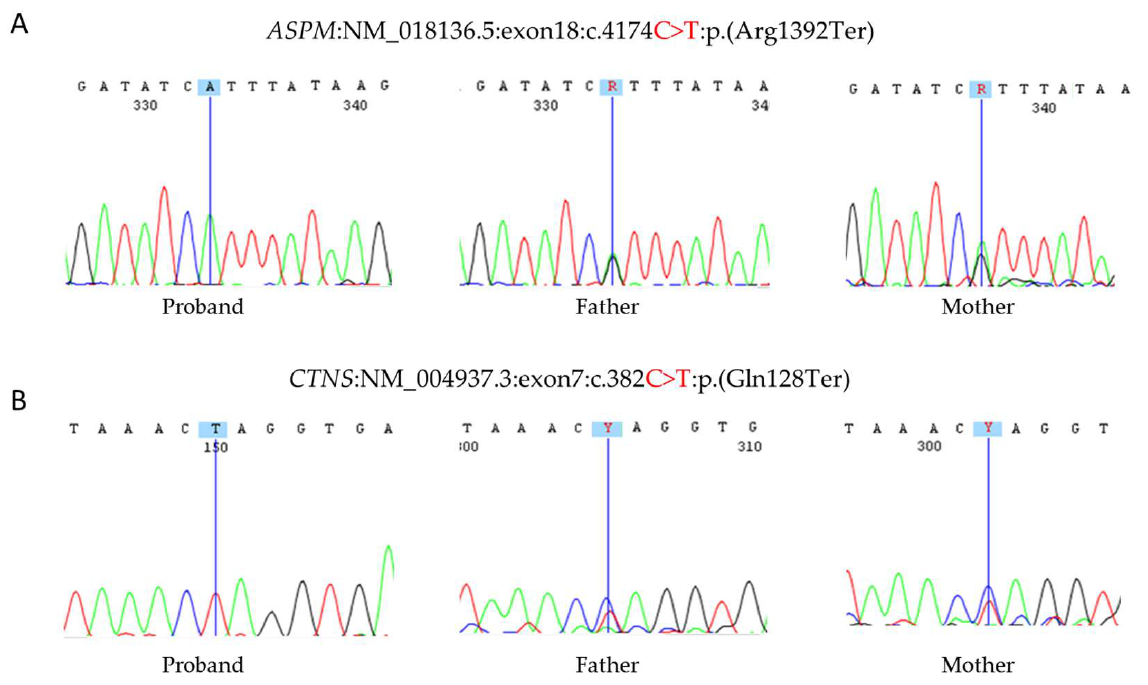
Figure 2. Sequence electropherograms of the trio for both variants. ( A ) c.4174C>T in the ASPM gene in homozygous state in the patient and heterozygous state in her parents. ( B ) c.382C>T in the CTNS gene in homozygous state in the patient and heterozygous state in her parents.